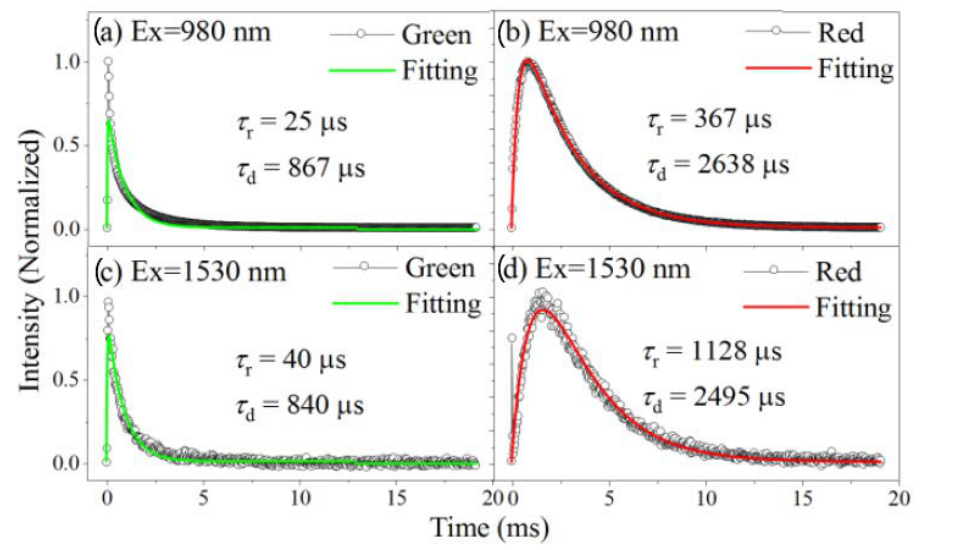
Figure 4. Time-resolved UCL of ( a ) green and ( b ) red emission upon 980 nm excitation and ( c ) green and ( d ) red emission upon 1530 nm excitation of the 10Er sample. The fitting curves, as well as the rise- and decay-times, are